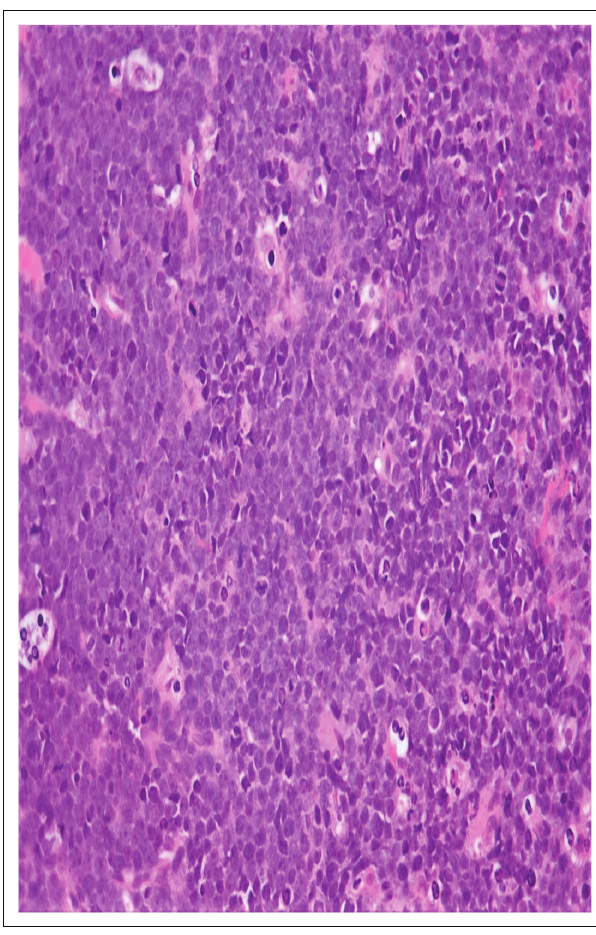
FIGURE 1: Tru-Cut biopsy of scalp mass of a 9-month-old male patient who presented to the Charlotte Maxeke Johannesburg Academic Hospital in February 2019. Image shows diffuse infiltration by intermediate-sized tumour cells with dispersed nuclear chromatin, irregular nuclear contours and one to four inconspicuous nucleoli. Numerous tingible body macrophages impart a starry sky pattern. 7 mitotic figures per 40 HPF. Haematoxylin & eosin (H&E) stain at ×40